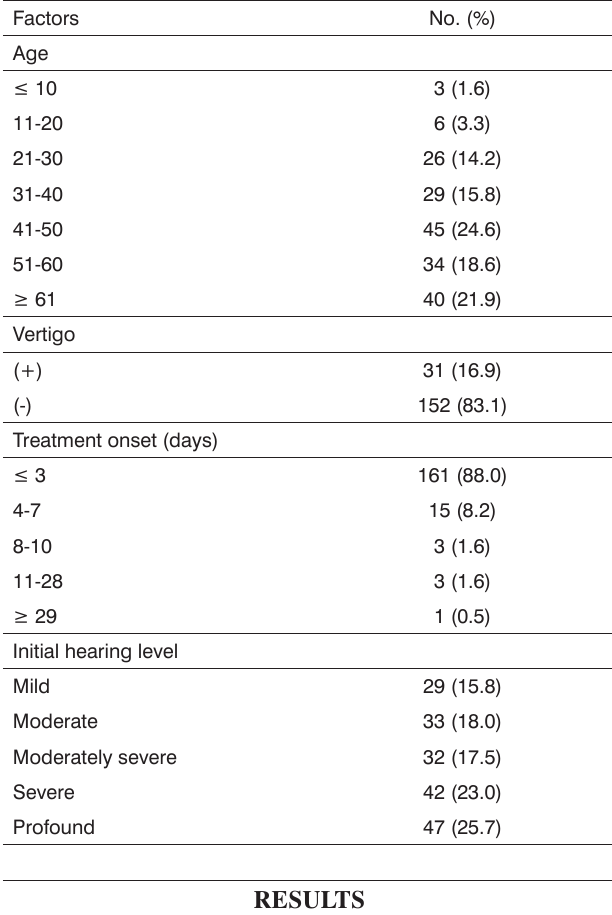
Table 1. Demographics and clinical characteristics of the study